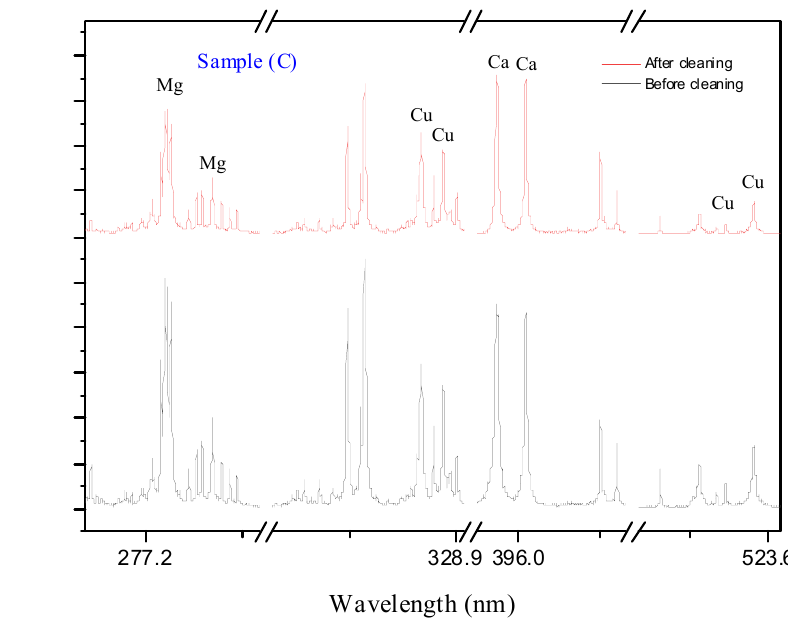
Figure 7. The LIBS spectra of the corroded coin sample (C) before and after cleaning.